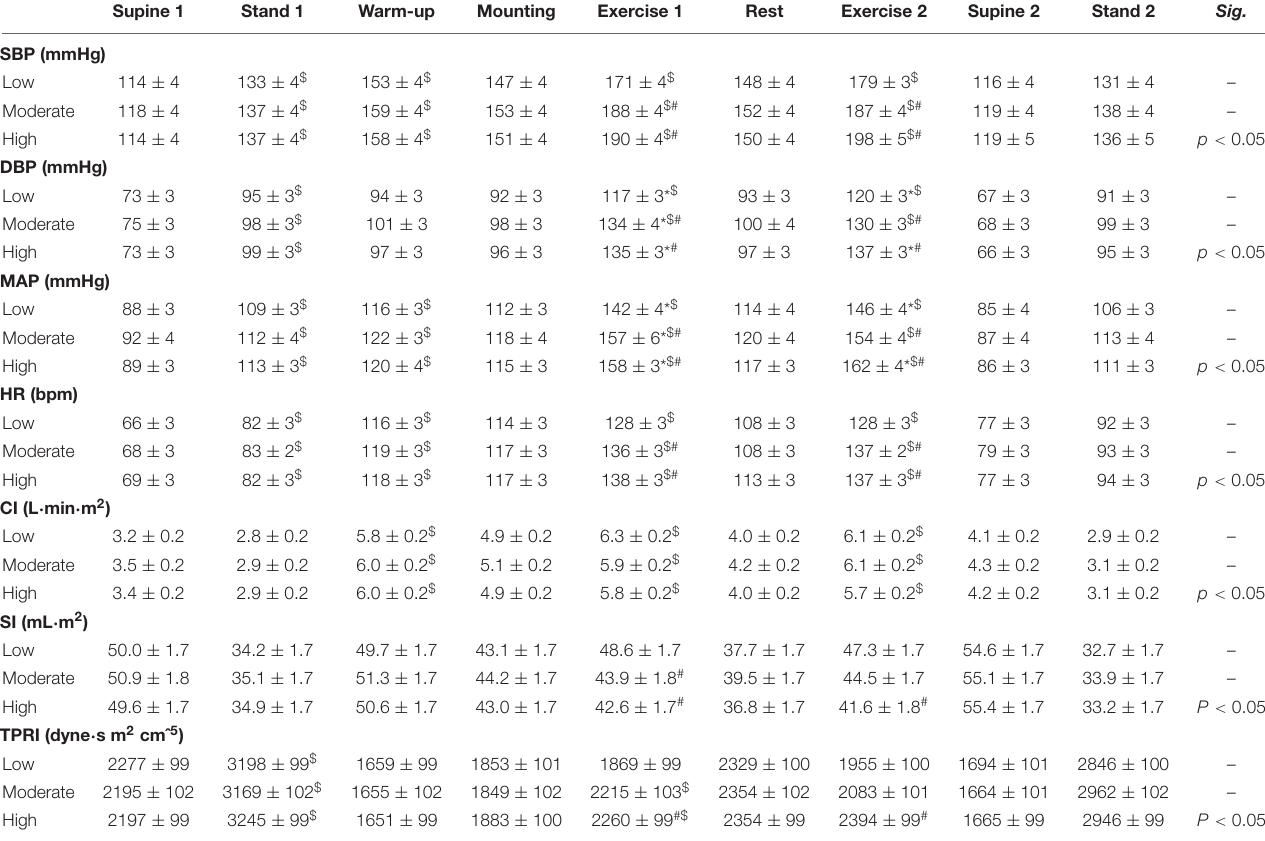
TABLE 2 | Average readings of the cardiovascular response to different levels of the flywheel exercise. Supine 1 Stand 1 Warm-up Mounting Exercise 1 Rest Exercise 2 Supine 2 Stand 2